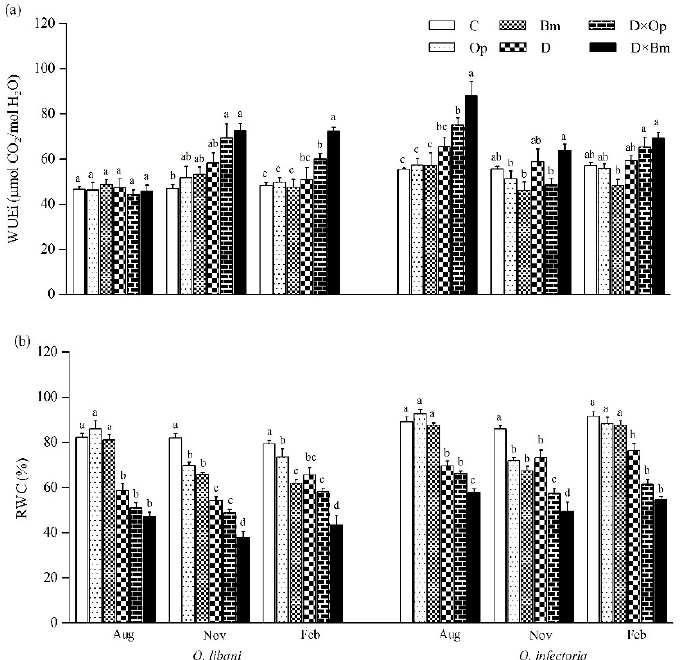
Figure 5. ( a ) Intrinsic water use efficiency (WUE i ) and ( b ) relative water content (RWC) of Quercus libani and Q. infectoria seedlings affected by charcoal disease, drought and their combination assessed at intervals of three months (starting three months after treatment initiation). Op: Obolarina persica , Bm: Biscogniauxia mediterranea , D: Drought, D × Op: Drought × O. persica and D × Bm: Drought × B. mediterranea . Bars represent means + standard error, n = 6. Different lower-case letters indicate statistically significant differences between the treatments at α = 0.05 based on Tukey’s multiple comparison